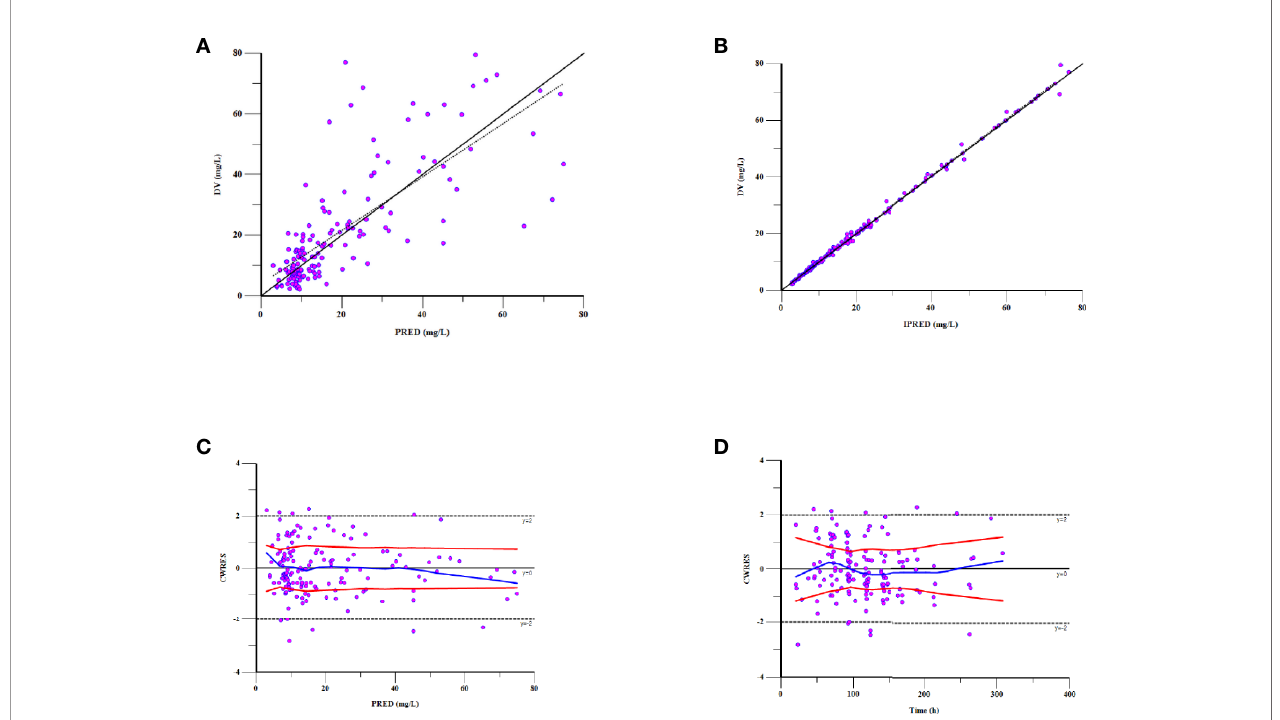
FIGURE 4 | Goodness-of- fi t plot for the fi nal population pharmacokinetics model. Observations against (A) population predictions (PRED) and (B) individual predictions (IPRED); (C) CWRES against PRED; (D) CWRES against time after the last dose.